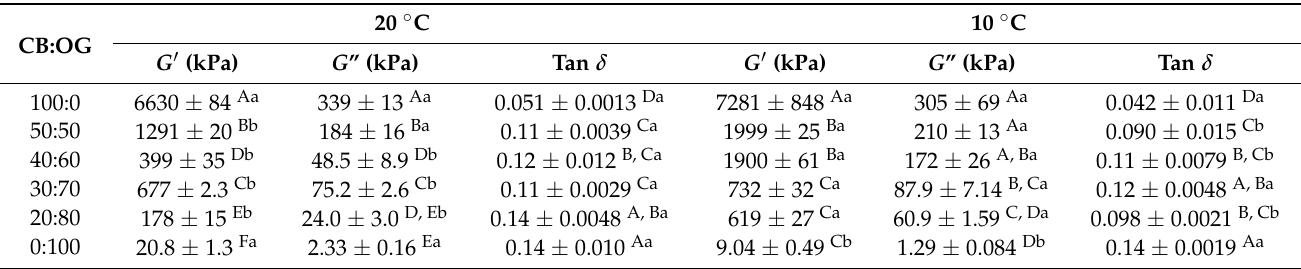
Table 2. Viscoelastic properties at 1 Hz and at 20 and 10 ◦ C derived from frequency sweeps for the different formulated CB:OG